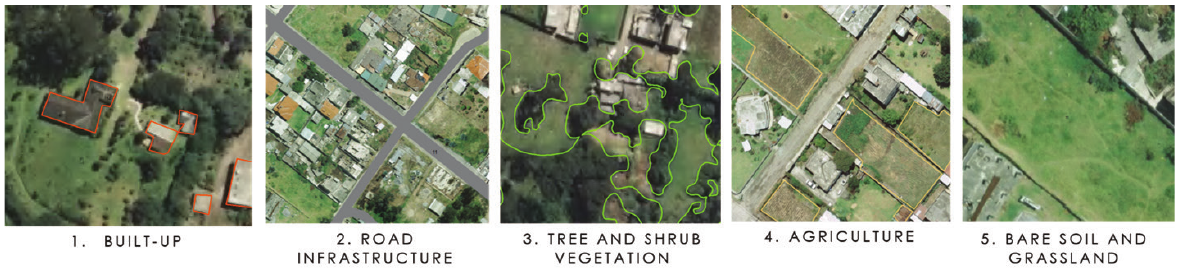
Figure 5. Visual identifi cation of Land Use Land Covers (source: by the authors)